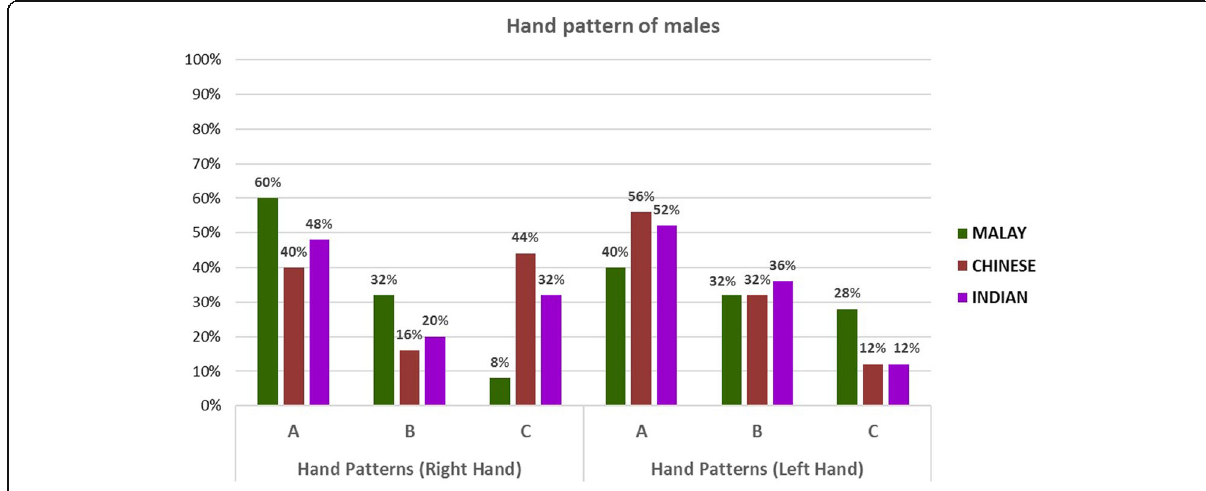
Fig. 2 Graph showing the percentage distribution of hand patterns of males between the three races